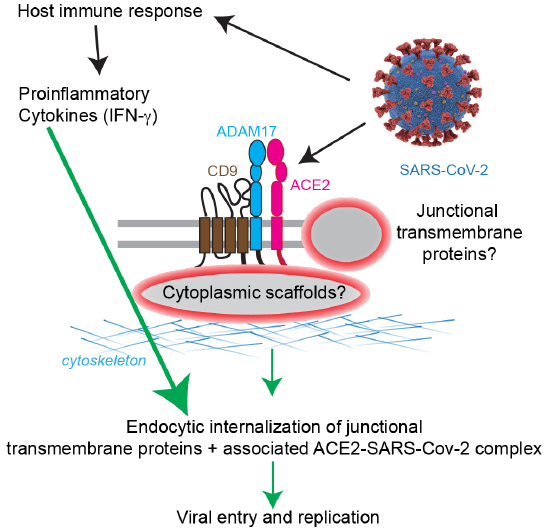
Figure 4. Scheme of working hypothesis. SARS-CoV-2 binds to the host cell receptor ACE2, which forms a complex with ADAM17 and CD9 at epithelial apical junctions. The identity of junctional transmembrane and cytoplasmic proteins associated with the complex and their role in the localization and internalization of ACE2, CD9 and ADAM17 is not known (grey/red ovals and question marks). SARS-CoV-2 elicits a host immune response, which entails the release of pro-inflammatory cytokines, which promotes endocytic internalization of junctional transmembrane proteins and associated complexes (green